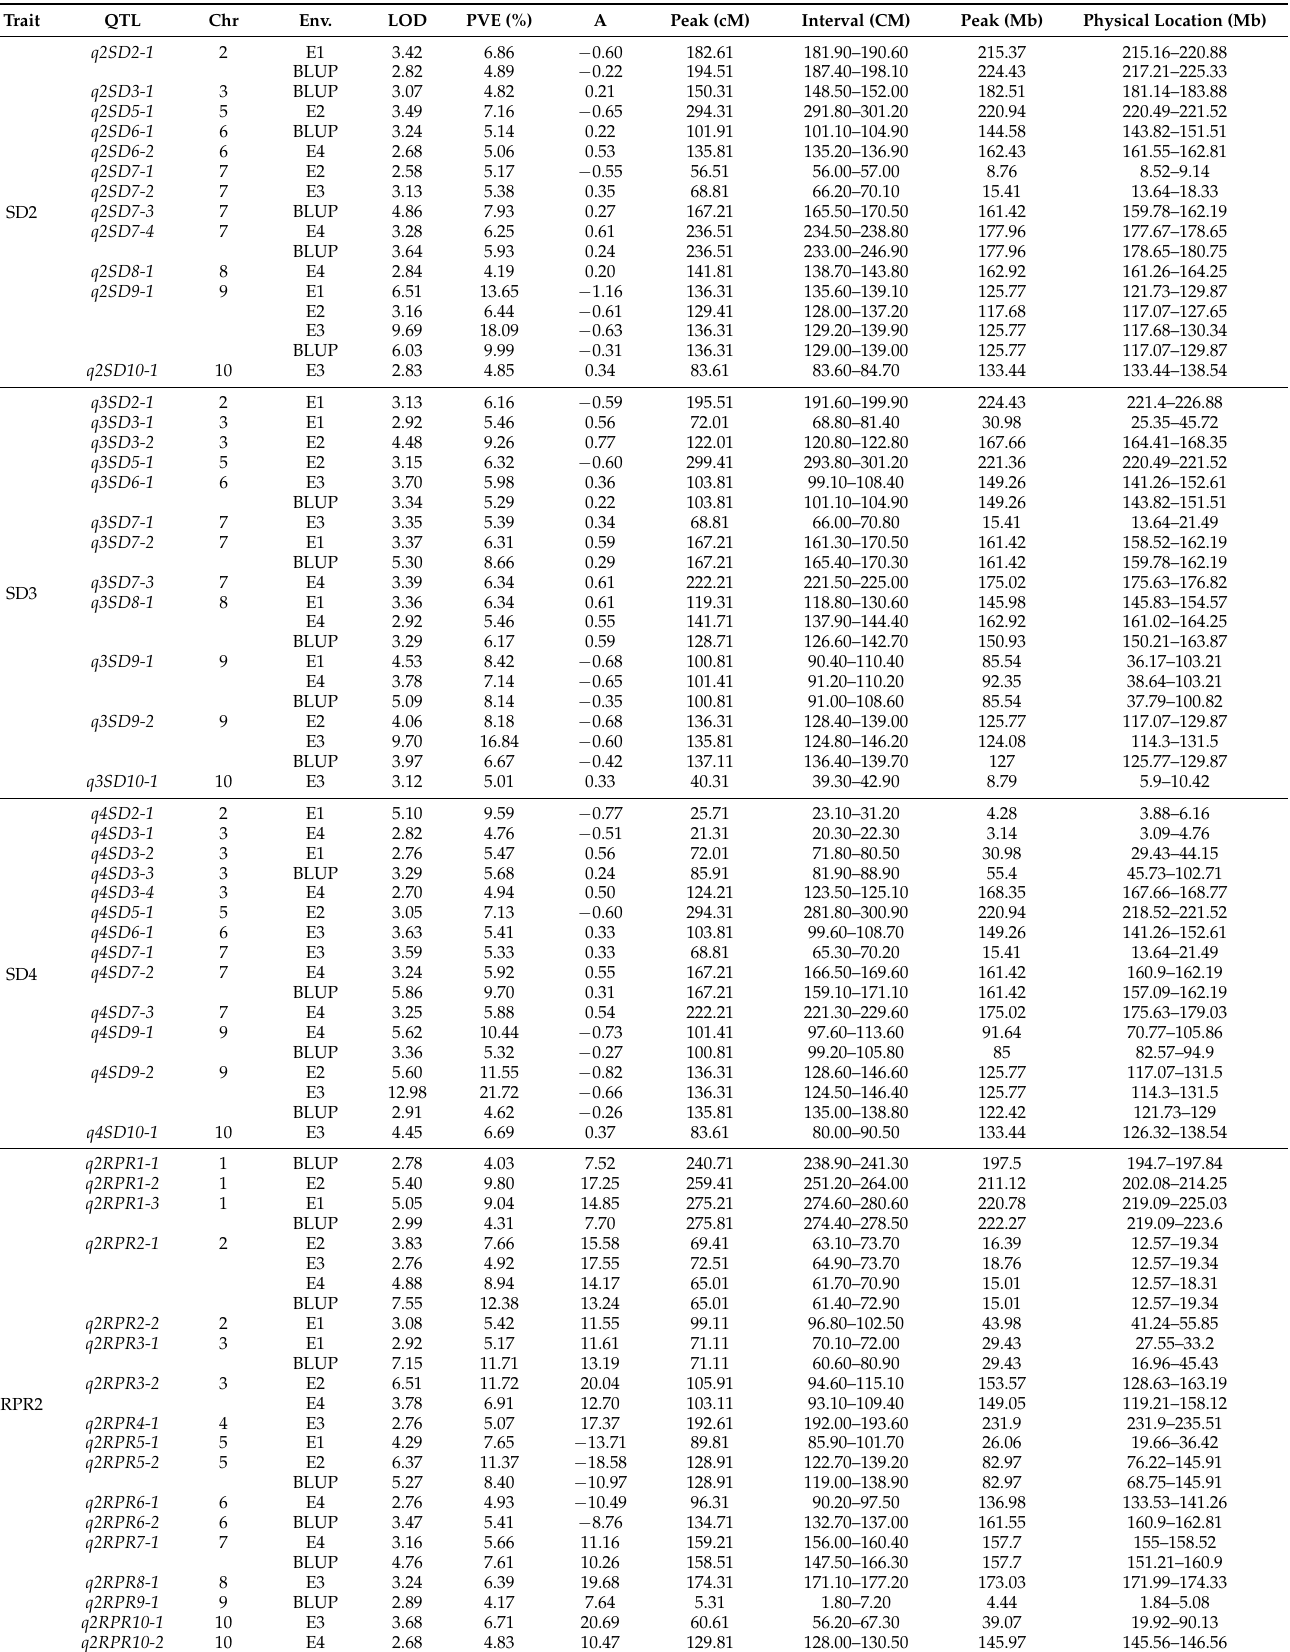
Table 2. Quantitative trait loci (QTLs) detected for SD and RPR across four environments and the BLUP